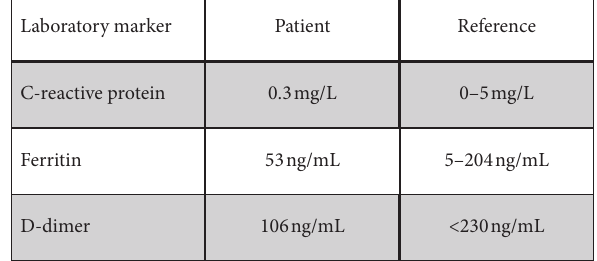
Figure 2: Inflammatory markers used to evaluate COVID-19 clinical recovery in SARS-CoV-2 seropositive transplant